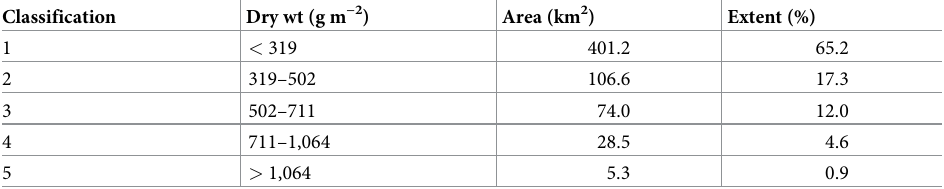
Table 2. Wetland classification and extent in the Yellow River Delta Nature Reserve based on dry weight of